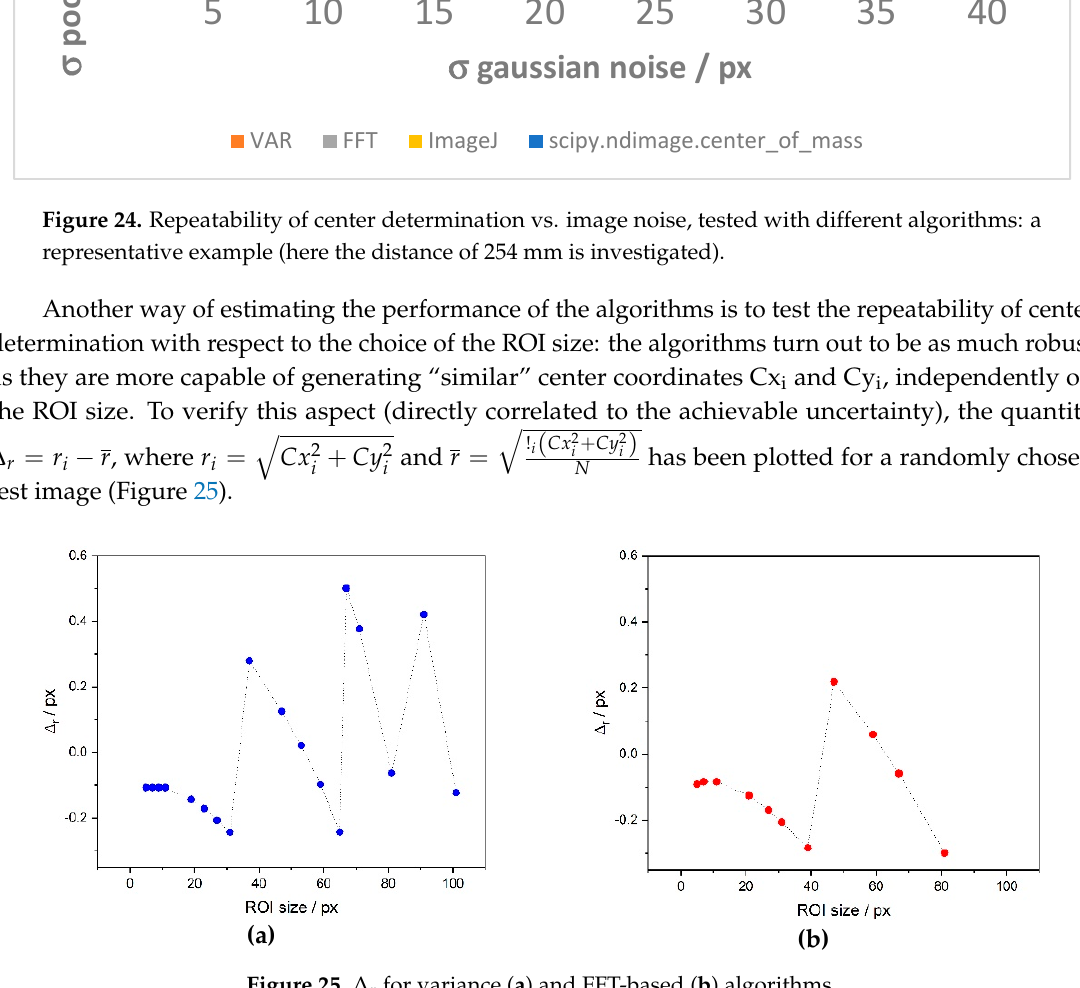
Figure 25. ∆ (cid:3045) for variance ( a ) and FFT-based ( b ) algorithms. Figure 25. ∆ r for variance ( a ) and FFT-based ( b )